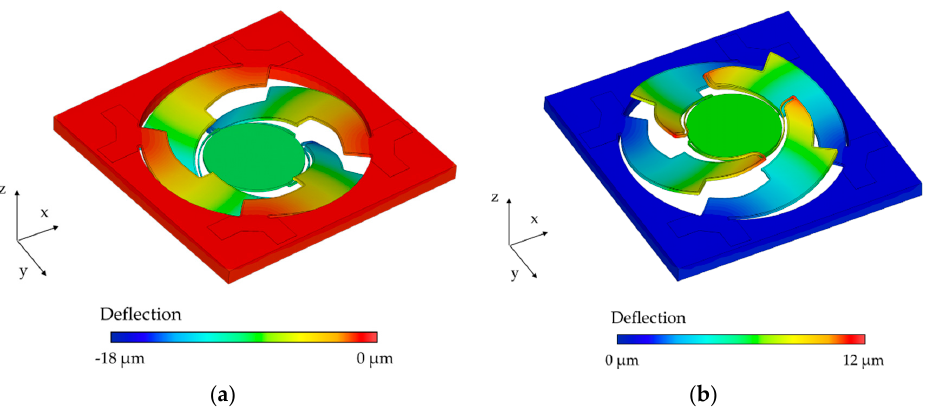
Figure 5. Simulated influence of intrinsic prestress on the actuator offset-deflection: ( a ) tensile stress at wafer center; ( b ) compressive stress at wafer edge.